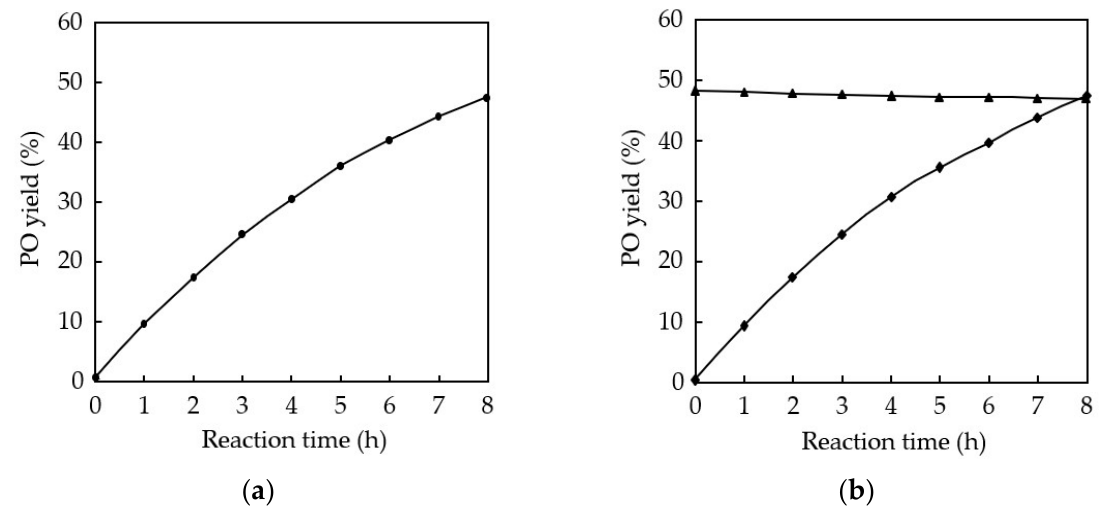
Figure 3. Stability of the solid catalyst Pd-PW-HAP for the propylene epoxidation by O 2 in methanol. ( a ) The first run with a fresh catalyst; ( b ) the second run with the used solid catalyst ( ♦ ) and the liquid without a solid catalyst ( ▲ ).